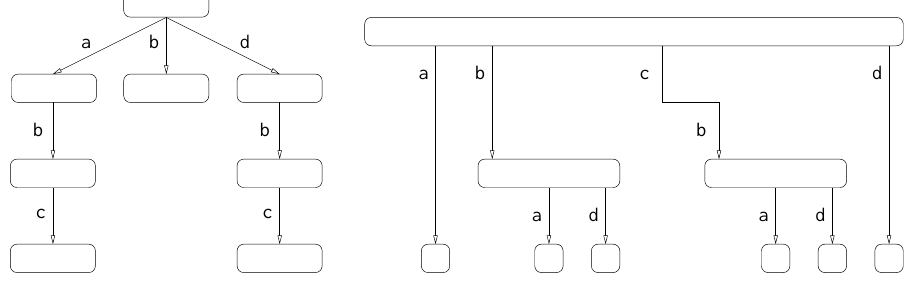
Figure 3. (left) LZ-trie for strings { a, b, ab, abc, d, db, dbc } . (right) Reverse tree of the LZ78